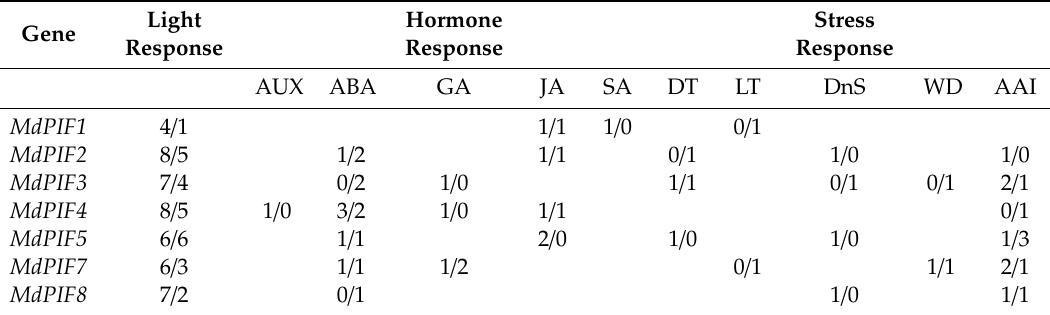
Table 2. Cis-acting element analysis in the MdPIF gene